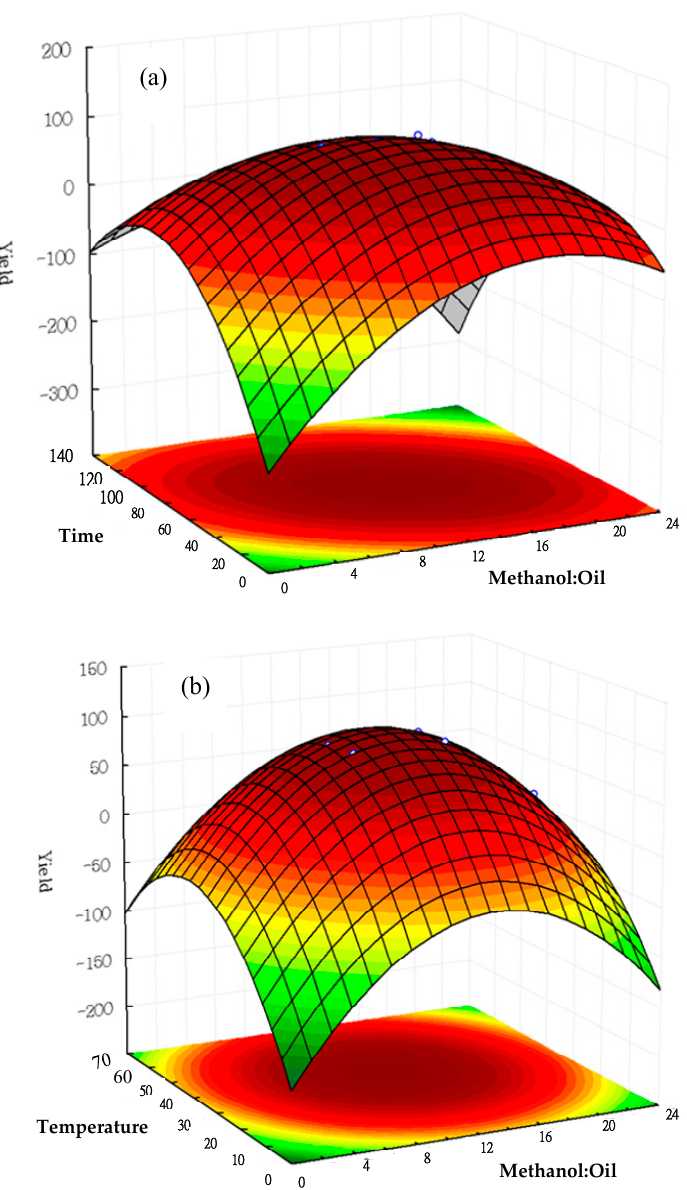
Figure 6. Response surface methodology on biodiesel production using 1:1 jatropha oil to castor oil as a feedstock. Plot ( a ) represents the significant interaction between reaction time (min) and methanol:oil ratio, the biodiesel yield is symbolized well in the plot. Plot ( b ) shows the temperature and methanol:oil ratio on the biodiesel yield.